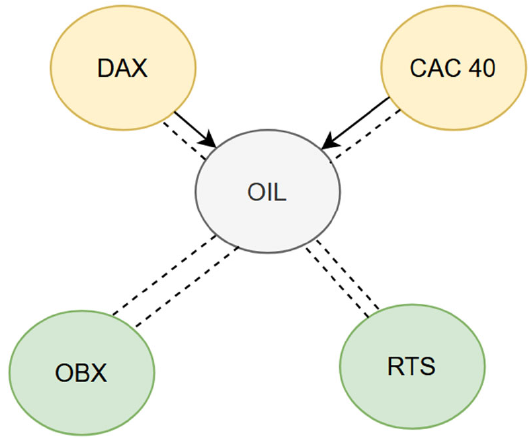
Figure 3. Granger causality results (pre-vaccine period).